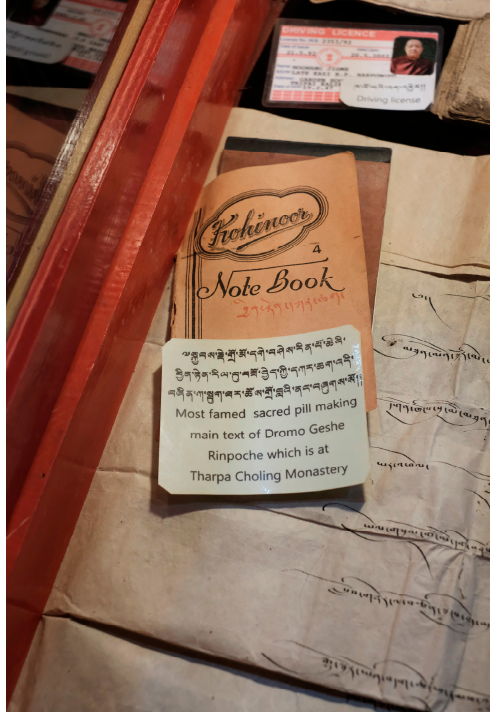
Figure 2. Domo Geshe Rinpoche’s notebook cover titled jinten karchak , referring to the list of ingredients required for the jinten pill. Tharpa Chöling Monastery Museum, Kalimpong, December 2018. Photo by author.